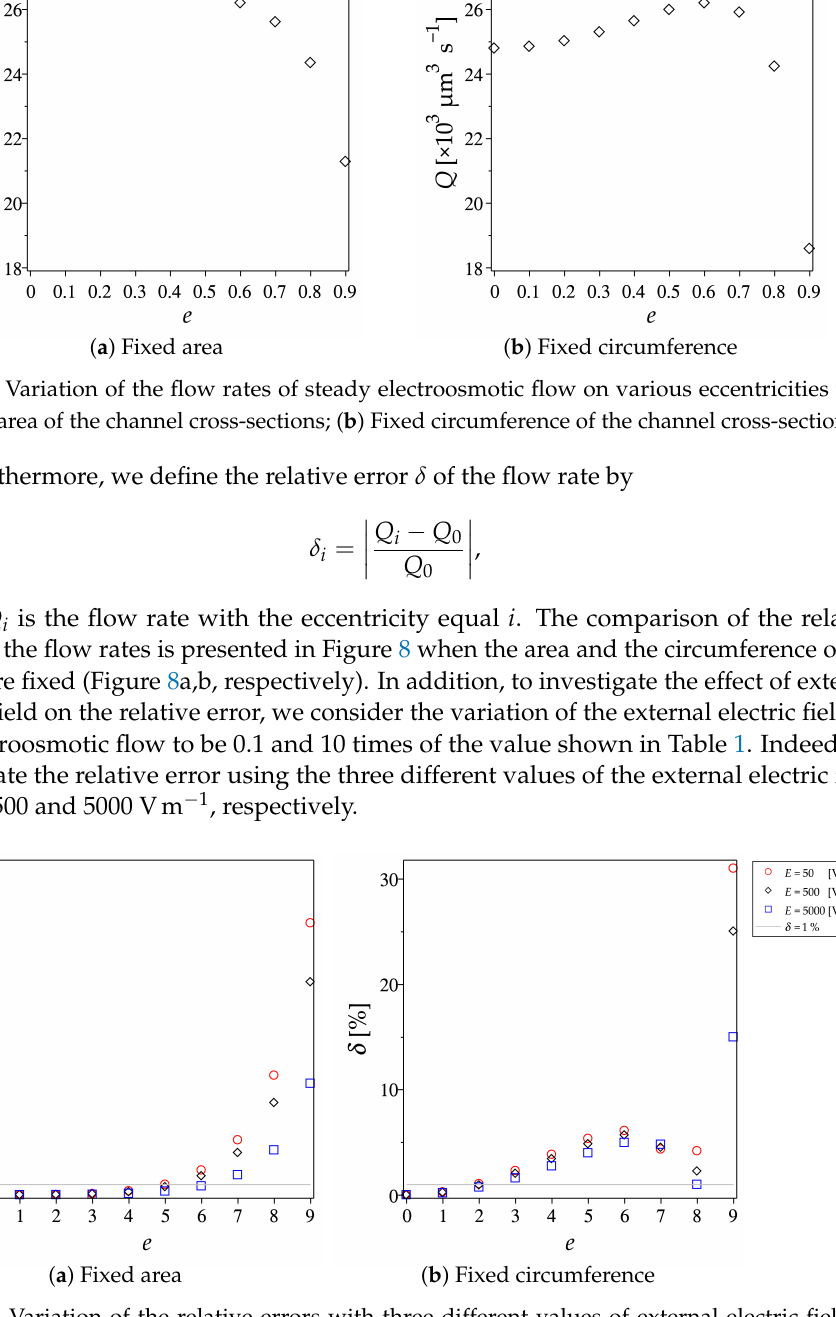
Figure 8. Variation of the relative errors with three different values of external electric field on various eccentricities with: ( a ) Fixed area of the channel cross-sections; ( b ) Fixed circumference of the channel